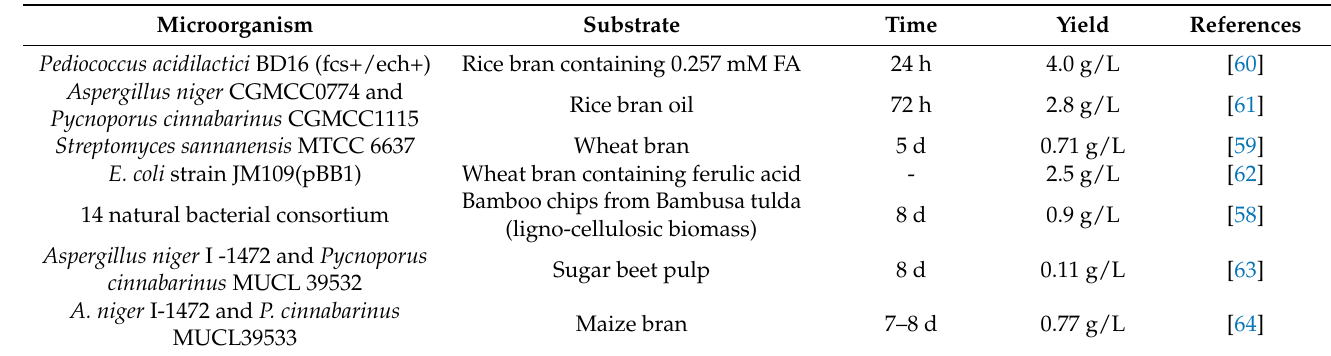
Table 2. Synthesis of vanillin from different